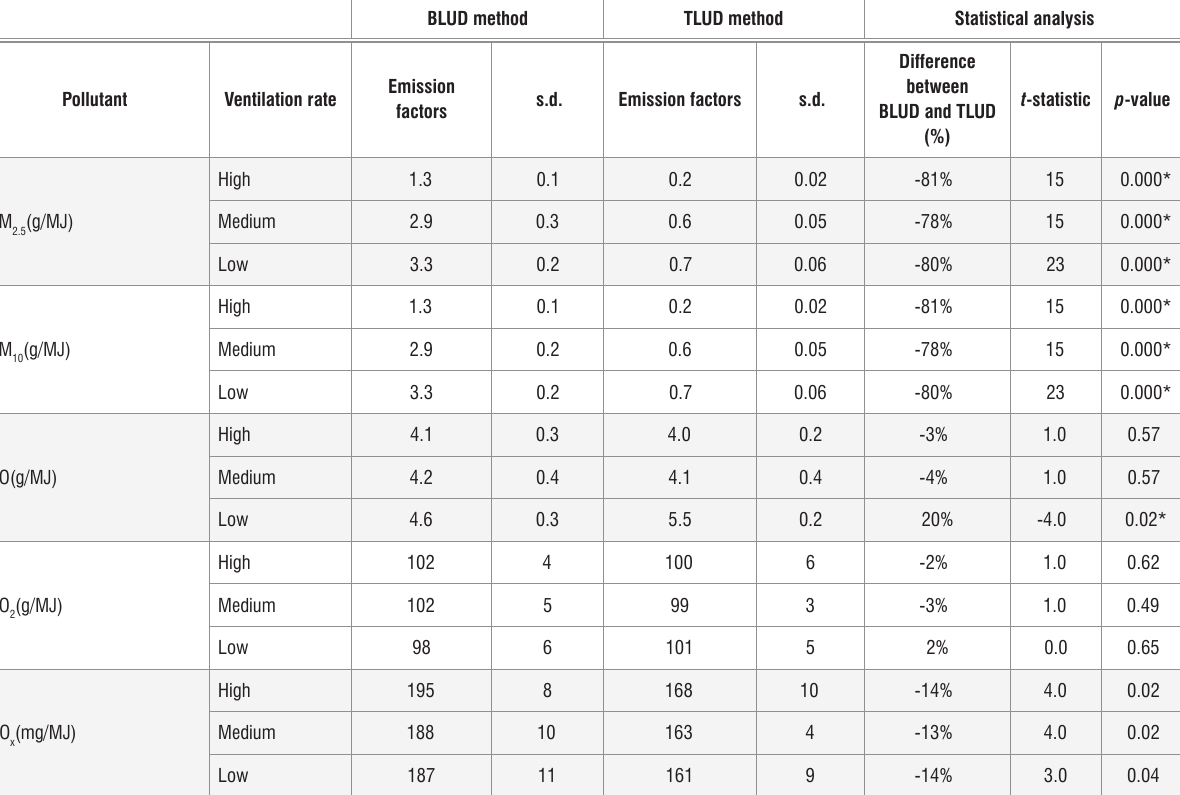
Particulate matter (PM) and gas emission factors for the field stoves using D-grade coal, for the top-lit updraft (TLUD) and bottom-lit updraft (BLUD) ignition methods at low, medium and high ventilation rates ( n